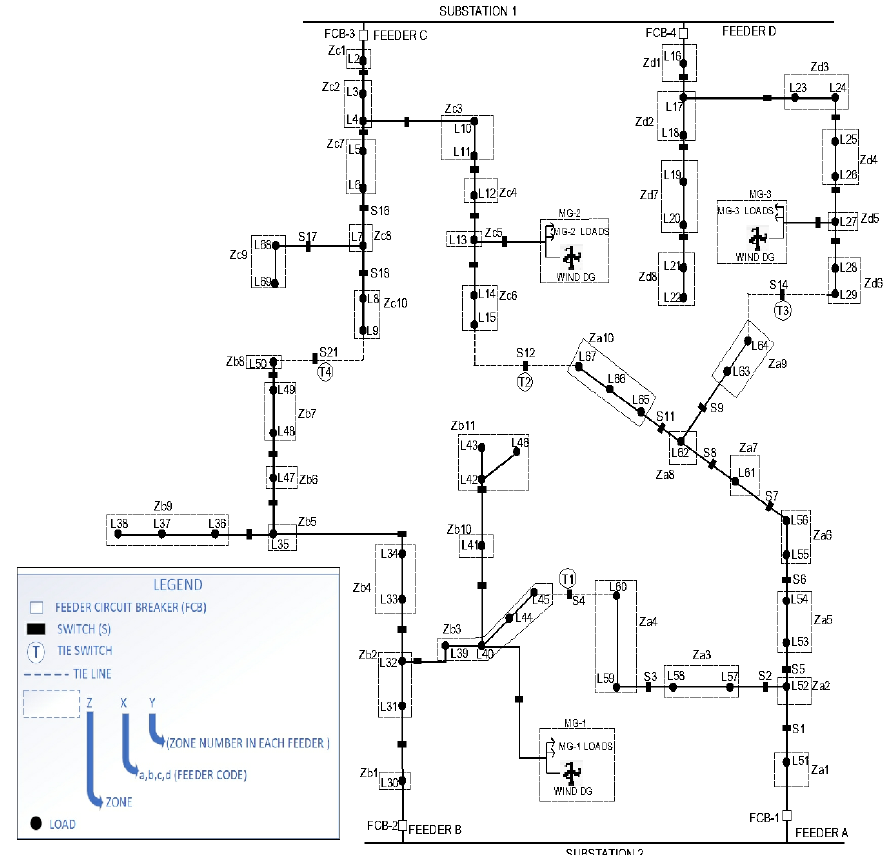
Figure 4. Distribution system under investigation.